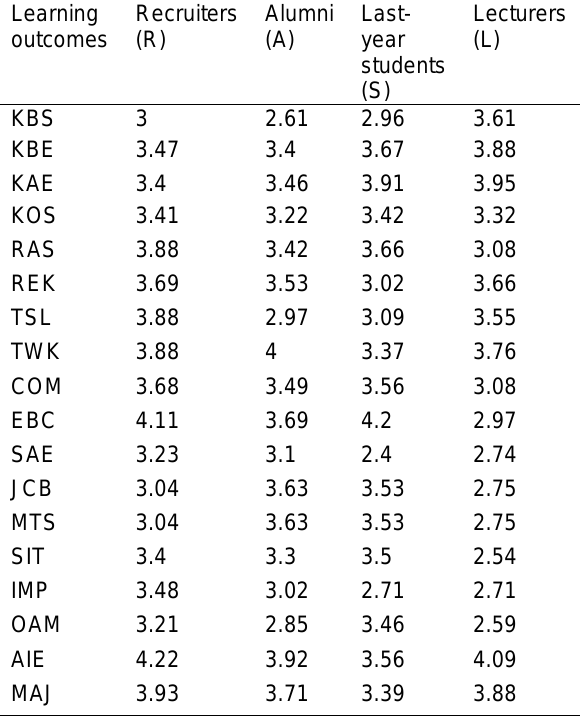
Table 3. The statistics on the interviewees’ cognition of the importance of learning outcomes (Source: Survey of Tuyet Anh Thi Nguyen in a study funded by TDMU in 2016)